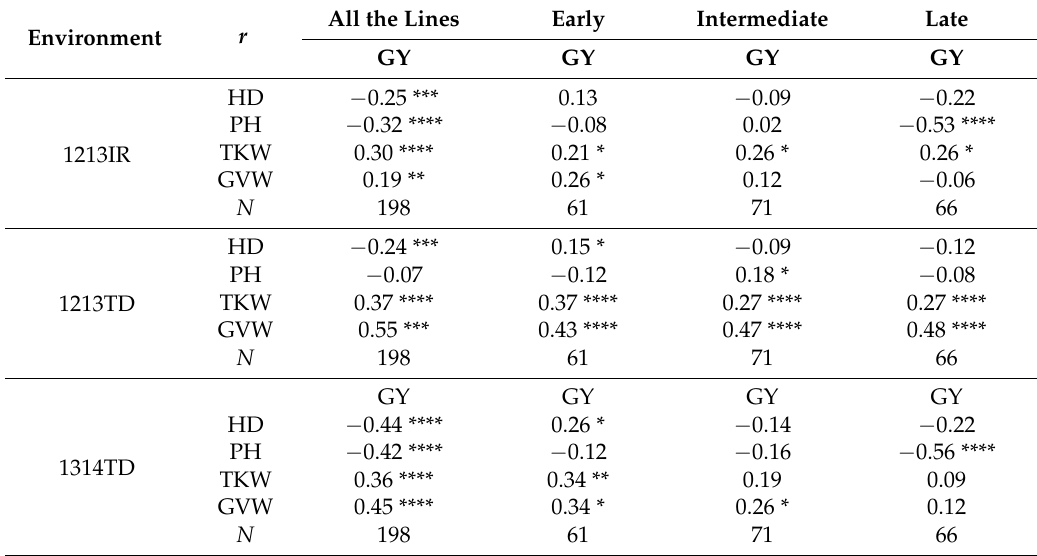
Table 4. Pearson’s correlation coefficients ( r ) between grain yield (GY) and traits investigated in the accessions of three maturity groups grown in three